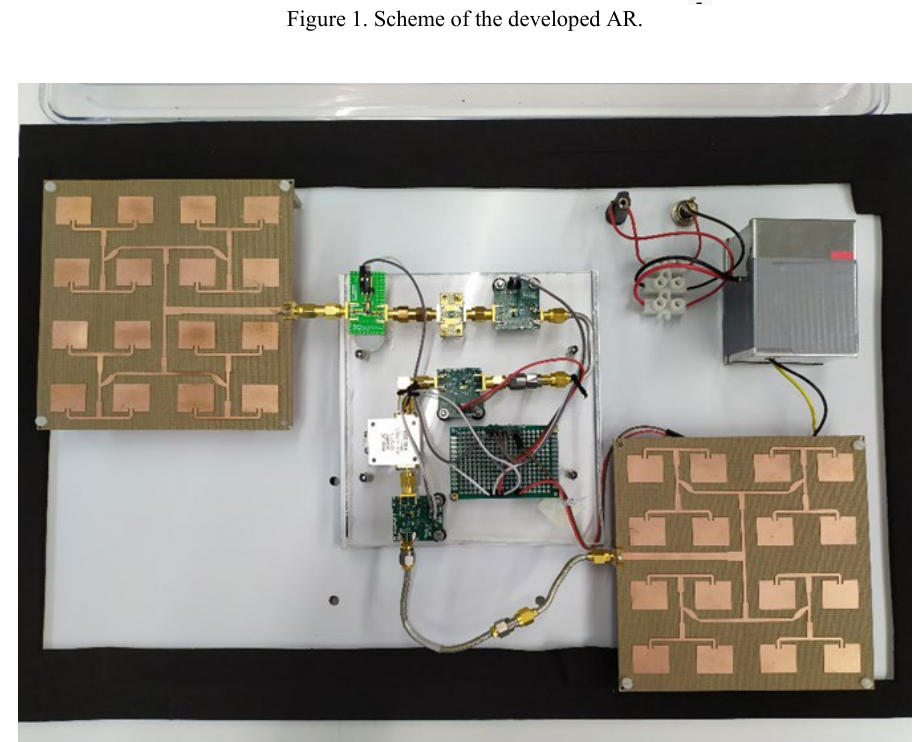
Figure 2. Antennas and amplifying section of one of the AR prototypes.